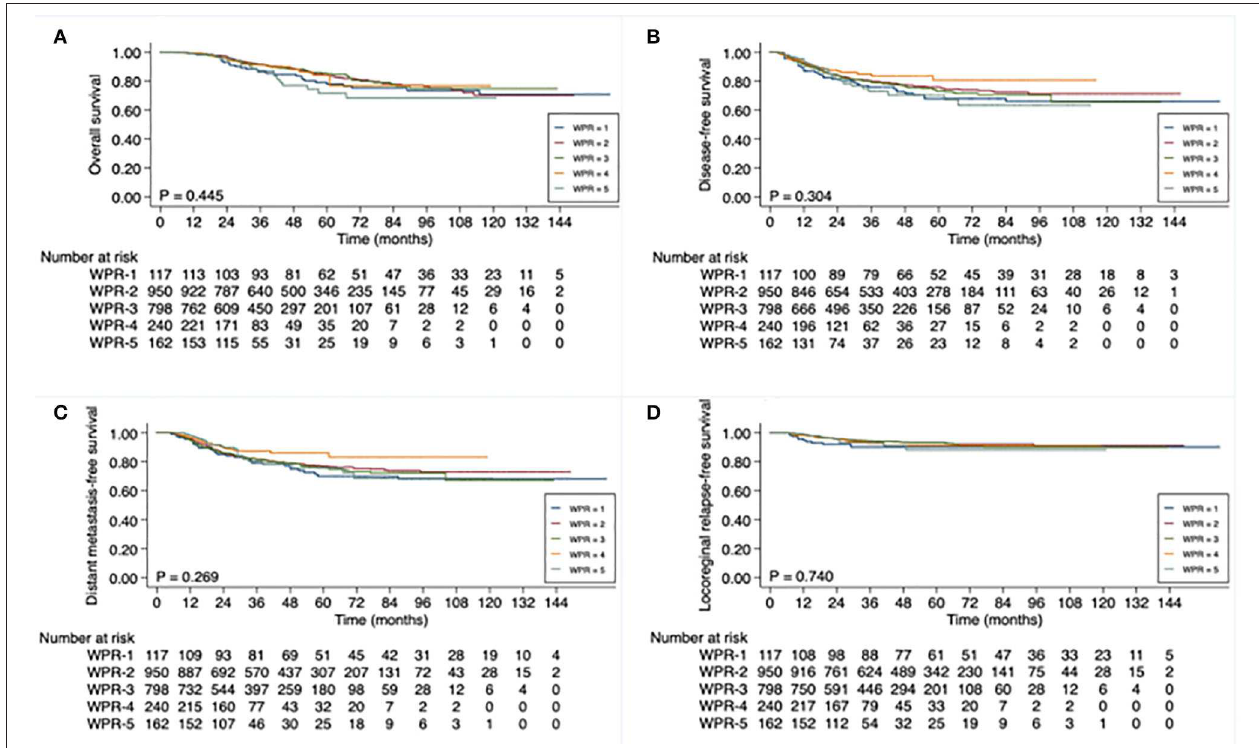
FIGURE 3 | Kaplan-Meier curve analysis of (A) overall survival, (B) disease-free survival, (C) distant metastasis-free survival, and (D) locoregional relapse-free survival (D) , based on waiting-period-after-radiotherapy (WPR), of 2,267 patients with locally advanced rectal cancer. WPR defined as time from end of neoadjuvant radiotherapy to date of surgery: 4 to < 6 weeks (WPR-1), 6 to < 8 weeks (WPR-2), 8 to < 10 weeks (WPR-3), 10 to < 12 weeks (WPR-4), and ≥ 12 weeks